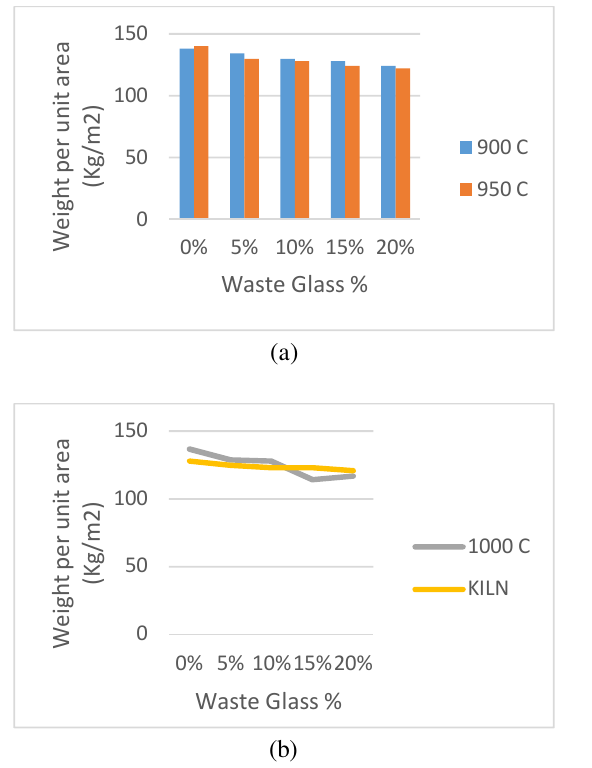
Fig. 8: Percent of waste glass added vs. weight per unit area at different temperatures